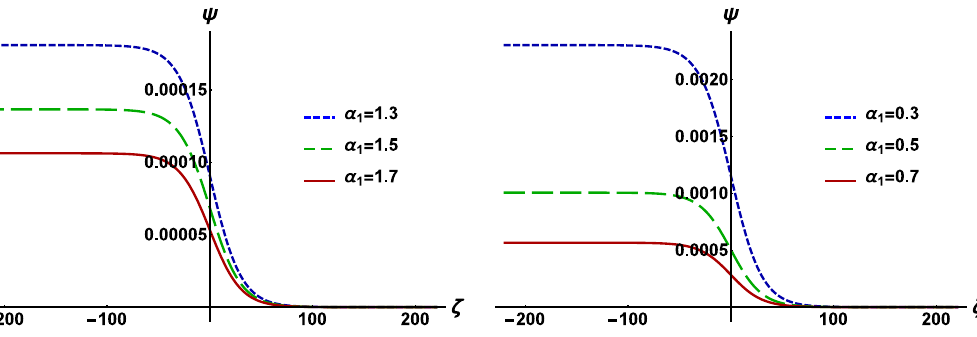
Figure 4. The variation of Ψ with ζ for different values of α 1 , i.e., α 1 > 1 ( left panel ) and α 1 , i.e., α 1 < 1 ( right panel ) under consideration of α 4 > α 4 c along with α 3 = 0.03, α 4 = 1.5, λ e = 1.7, λ p = 1.5, λ d = 0.05, δ = 30 ◦ , η = 0.3, α = 0.5, U 0 = 0.01, and V p ≡ V p + .